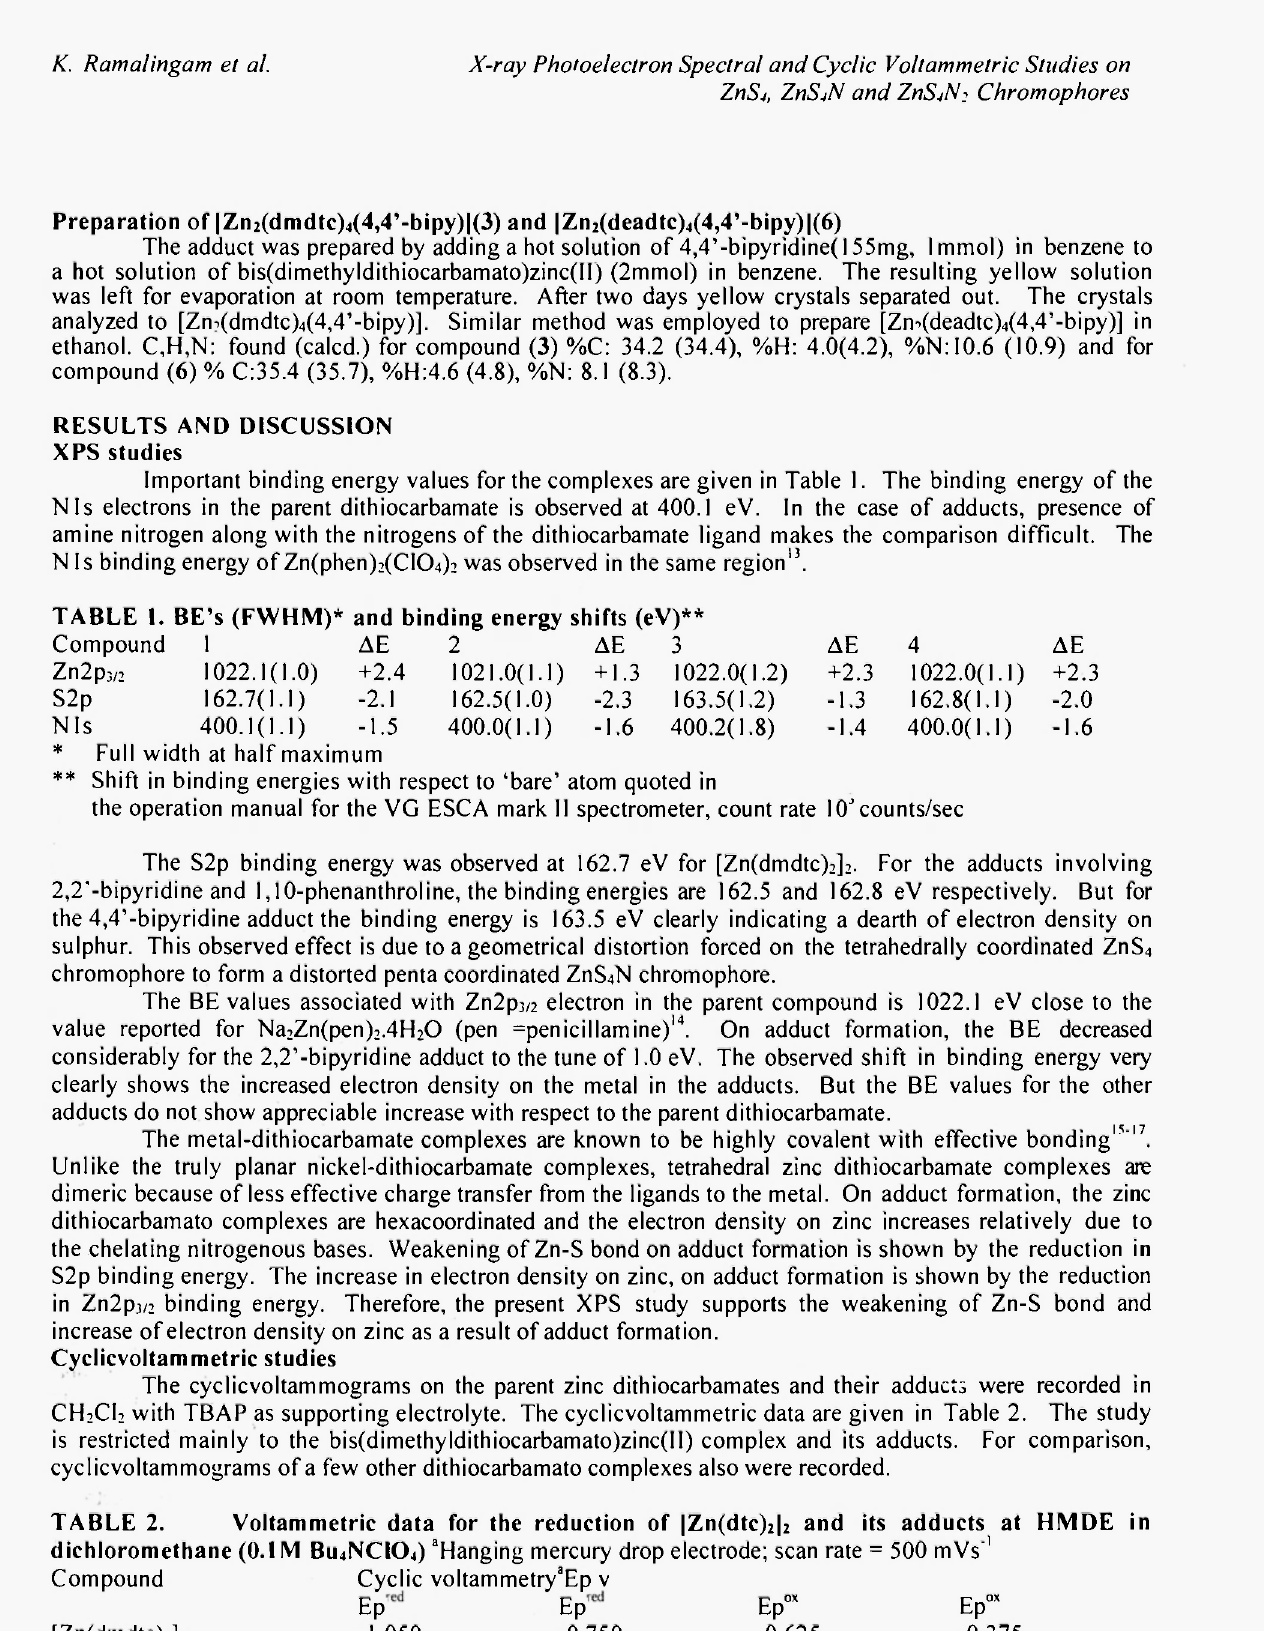
Voltammetric data for the reduction of |Zn(dtc) 2 | 2 and its adducts at HMDE